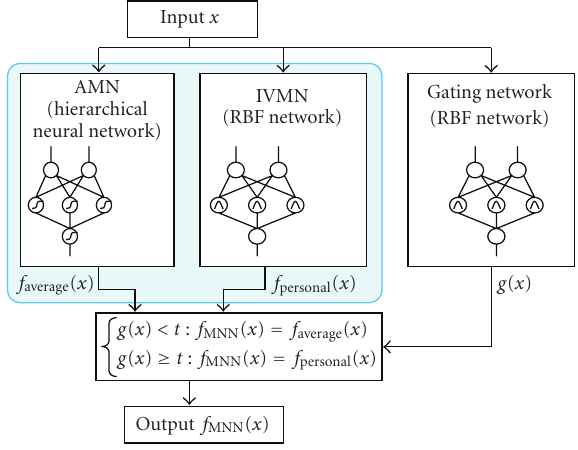
Figure 5: Concept figure on